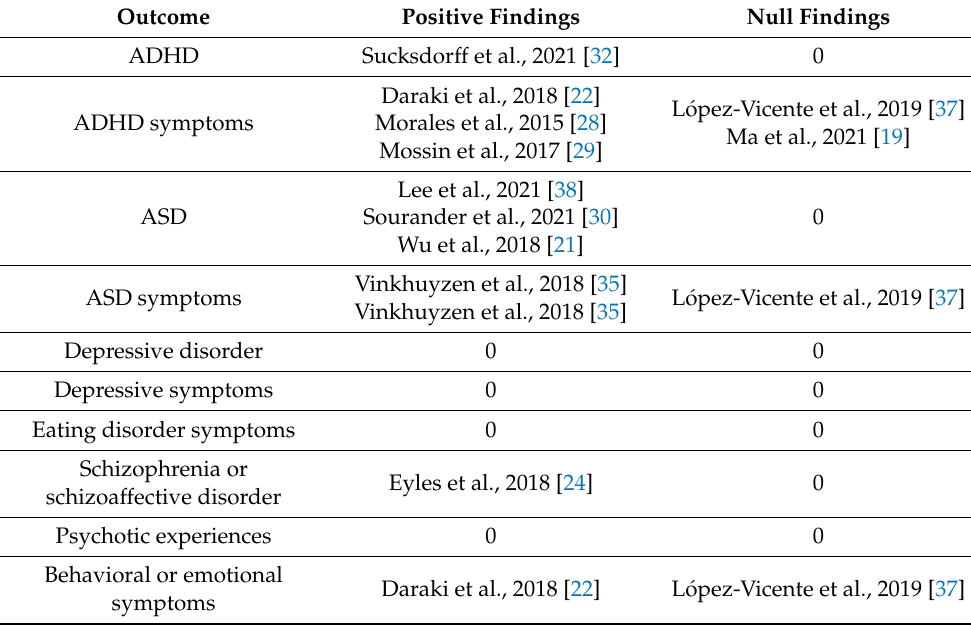
Table 3. Large studies with stricter definitions for vitamin D deficiency. Only studies that had defined vitamin D deficiency as ≤ 40 nmol/L and had at least 100 mothers in the deficiency group were included. An additional limit for the diagnostic outcomes was to have at least 100 cases for the studied outcome. Outcome Positive Findings Null